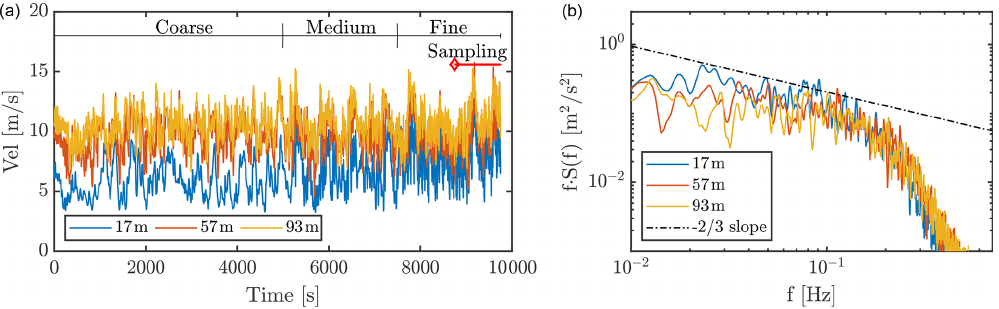
Figure 6. (a) Time series of wind speed, W , at three altitudes, approximately matching the rotor bottom, center, and top altitudes. (b) Spectra of wind speed time series (fine-resolution period only) using the Welch estimate.